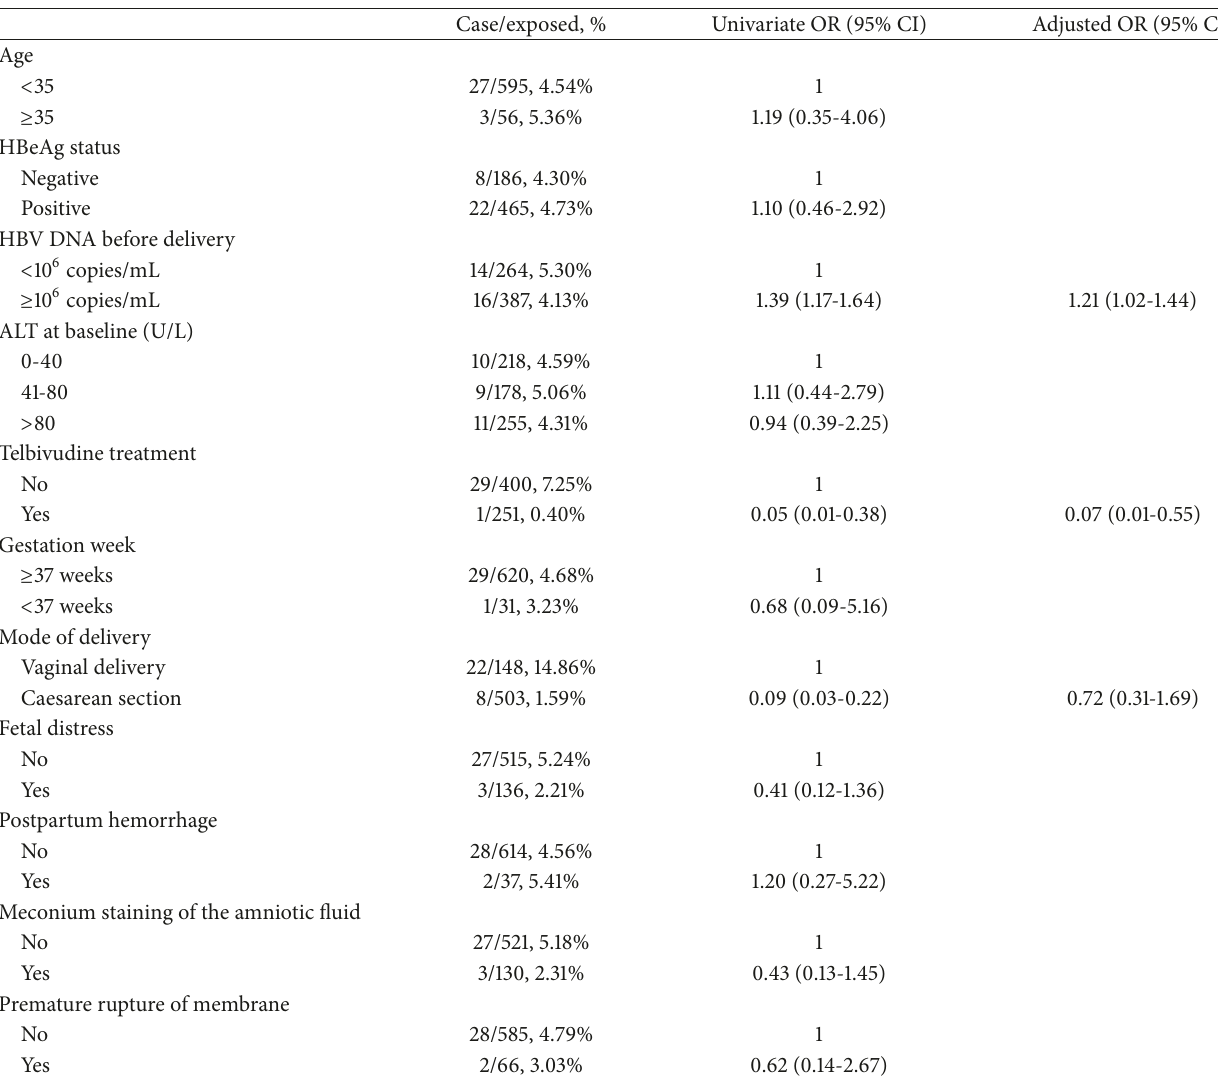
Table 5: Risk factors for MTCT of